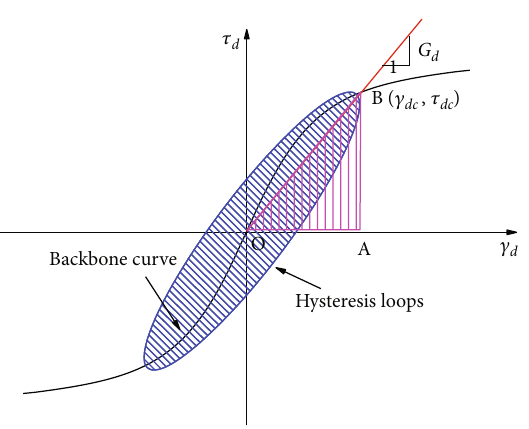
Figure 3: Schematic diagram of hysteresis